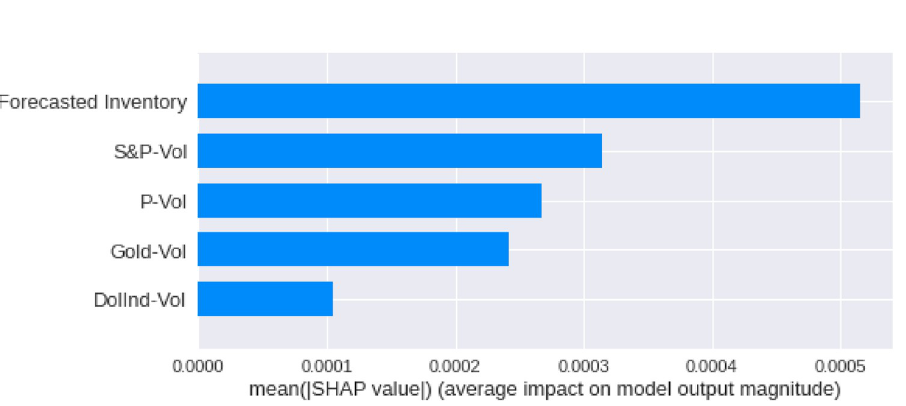
Fig 23. Mean Shapley values for the fifth previous day using Nadam optimizer.